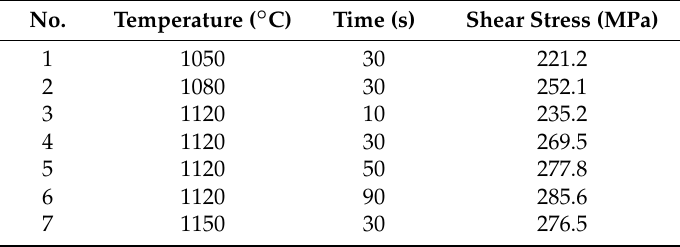
Table 3. Shear test results of the brazed joints for different process parameters.